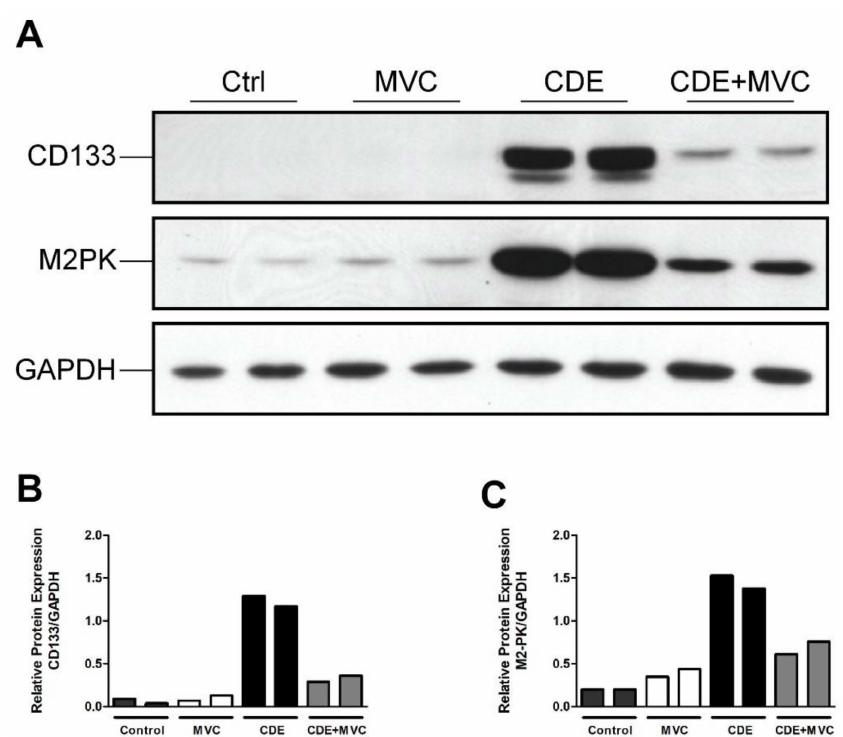
Figure 3. The protein expression of LPC markers is attenuated by MVC in CDE liver. ( A ) Protein lysates from livers of two mice fed either control, CDE, MVC or CDE+MVC diets for 16 weeks were immunoblotted and labelled for CD133, M2PK and the loading control GAPDH. ( B , C ) Abundance of CD133 and M2PK relative to GAPDH, as calculated through densitometry performed on the images in ( A